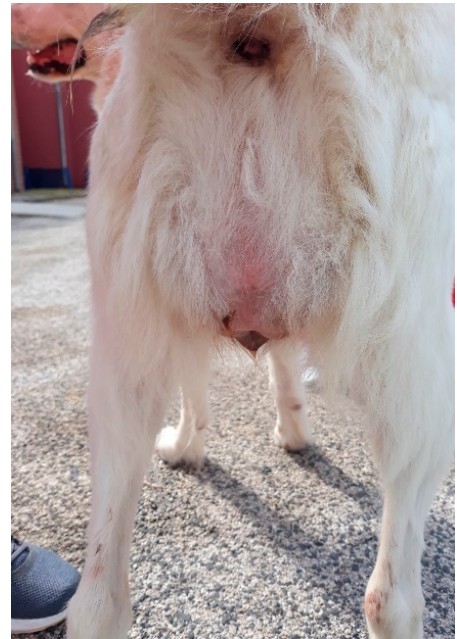
Figure 7. Recrudescence of vaginal hyperplasia. Bühner suture proved to be useful for the prevention of a new prolapse through the vulvar lips.